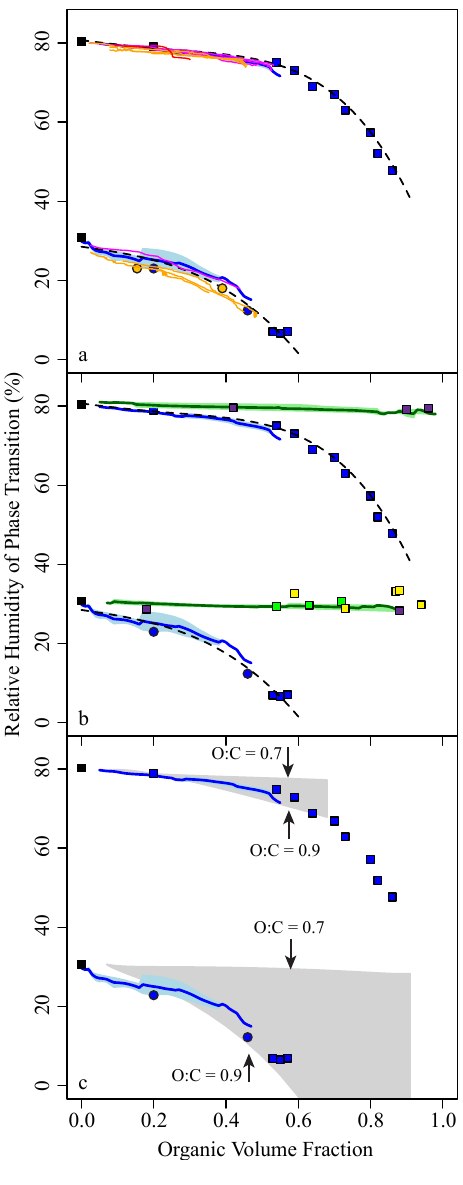
Fig. 5. Additional results and comparison to the literature for the deliquescence and efflorescence relative humidities of ammonium sulfate when mixed with SOM. Blue lines and points reproduce the data set of Fig. 4. (a) Additional results for SOM produced by iso- prene photo-oxidation at 60%RH with solid sulfate seed particles (magenta), at 40%RH with aqueous sulfate seed particles (red), and at 60%RH with aqueous sulfate seed particles (orange). (b) Litera- ture results of DRH( ε ) and ERH( ε ) for ammonium sulfate mixed with ozonolysis products of α -pinene (green shading and lines, Smith et al., 2011; green points, Takahama et al., 2007), limonene (yellow points, Takahama et al., 2007), and β -caryophyllene (purple points, Bertram et al., 2011). (c) Comparison between the observa- tions of this study and the predictions of Bertram et al. (2011) for DRH( ε ) and ERH( ε ) based on O:C ratio (gray shaded area). The upper limit of the gray areas corresponds to the prediction for an O:C of 0.7 and the lower limit is the prediction for O:C of